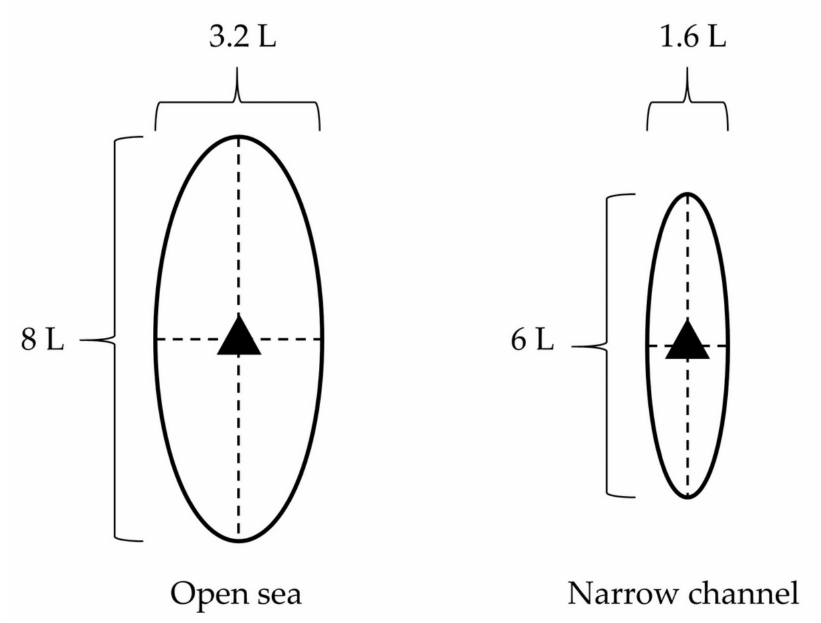
Figure 4. Fujii ship domain that distinguishes between open sea and narrow channels. Created by the description presented in